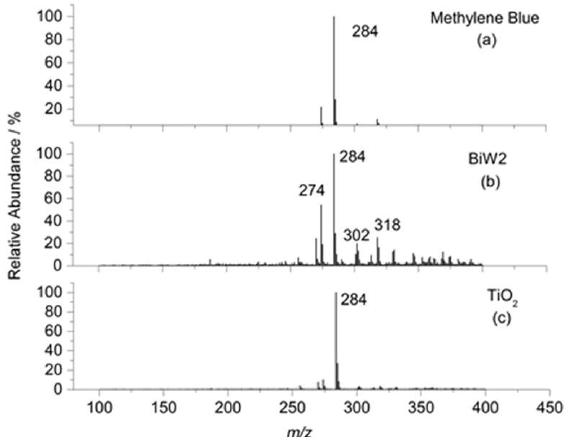
Figure 11. ESI-(+)-MS: ( a ) methylene blue; ( b ) fragmentation products of MB photocatalytic degradation in the presence of the sample BiW2; and ( c ) fragmentation products of MB photocatalytic degradation in the presence of the sample TiO 2 .